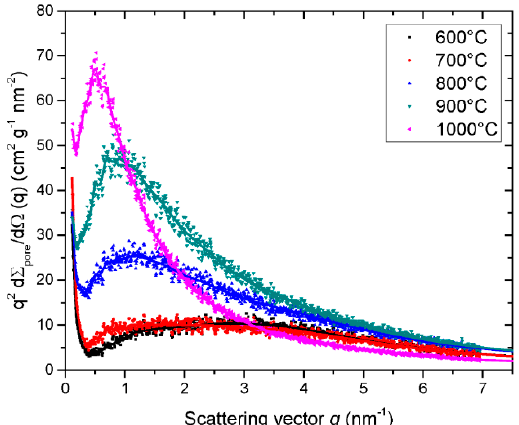
Figure 6. Analysis of CDCs by SAXS in terms of the chord length distribution. Kratky plots of the pore scattering data from Figure 4 vs. scattering vector. The solid lines display the respective fits by the chord length distribution shown in Figure 7. Table 1 summarizes the parameters derived from this analysis. The color coding indicated in the graph refers to the di ff erent temperatures at which the CDCs have been synthesized. Reproduced with permission from [75] copyright © 2019,